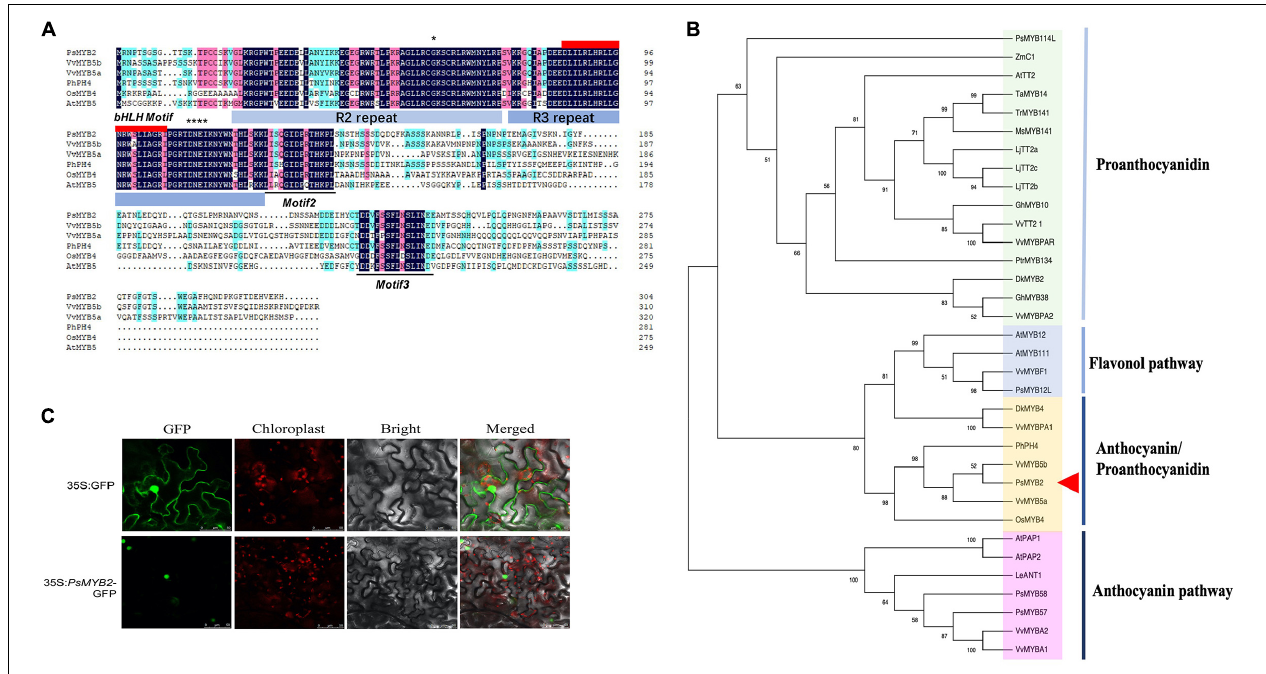
FIGURE 6 | Sequence analyses of PsMYB2 . (A) Protein sequence alignment analysis of the PsMYB2. Sequence alignment was performed using the DNAMAN software of version 6. GenBank accession numbers of these MYB proteins were as follows: VvMYB5b, Vitis vinifera , AAX51291.1; VvMYB5a, Vitis vinifera , AAS68190.1; PhPH4, Petunia hybrida AAY51377.1; OsMYB4, Oryza sativa , BAA23340.1; AtMYB5, Arabidopsis thaliana , NP_187963.1. (B) Phylogenetic analysis of PsMYB2 with MYB transcription factors from other species. The phylogenetic tree was constructed with MEGA11 software through neighbor-joining method